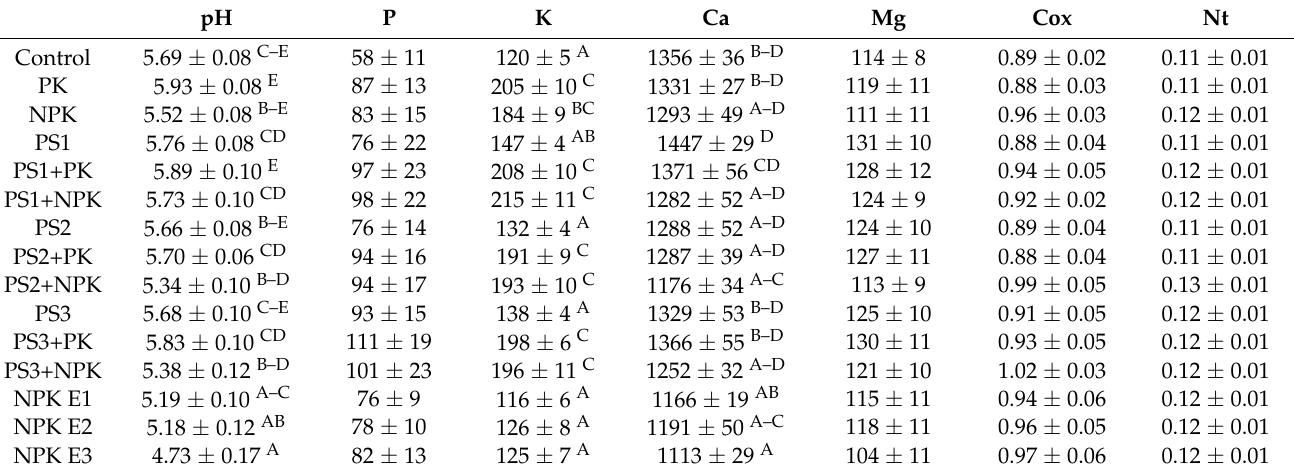
Mean values ( ± SE) followed by the same letter (a vertical comparison of the effect of fertilizer treatment) are not statistically significantly different. Columns without letters (P, Mg, Cox, Nt) represent values without statistically significant differences, where the effect of fertilizer treatments was insignificant.